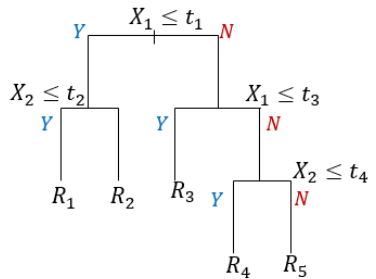
Figure 5. Decision tree.